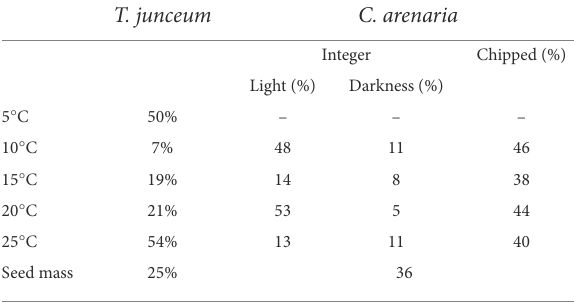
TABLE 5 Ratio of within-population variability to total variability for seed germination at each tested condition and for seed